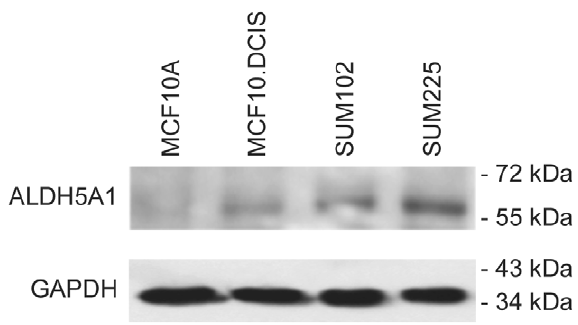
Figure 5. ALDH5A1 is over-expressed in DCIS models. Whole cell lysates from 3D rBM overlay cultures of MCF10A, MCF10.DCIS, SUM102 and SUM225 were probed for ALDH5A1 (upper panel) and for GAPDH (lower panel) as a loading control. Densitometry indicated that ALDH5A1 levels in the lysates of MCF10.DCIS, SUM102, and SUM225 were 2.7, 3.1, and 7.3-fold over that in MCF10A in this representative experiment. In three independent analyses of MCF10.DCIS 3D rBM cultures, the mean increase in ALDH5A1 over control was